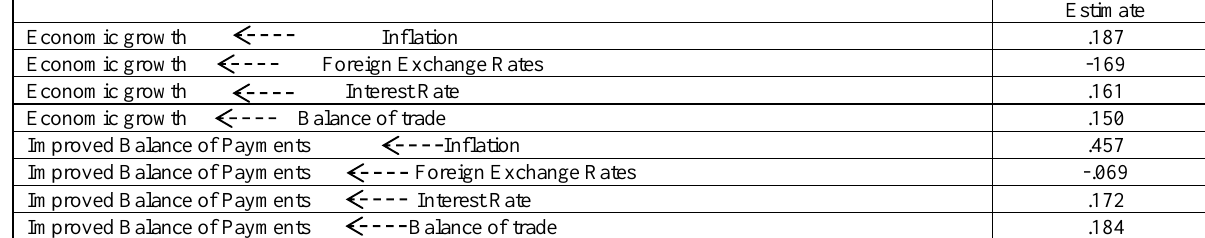
Table 4. Standardized Regression Weights Composite Model